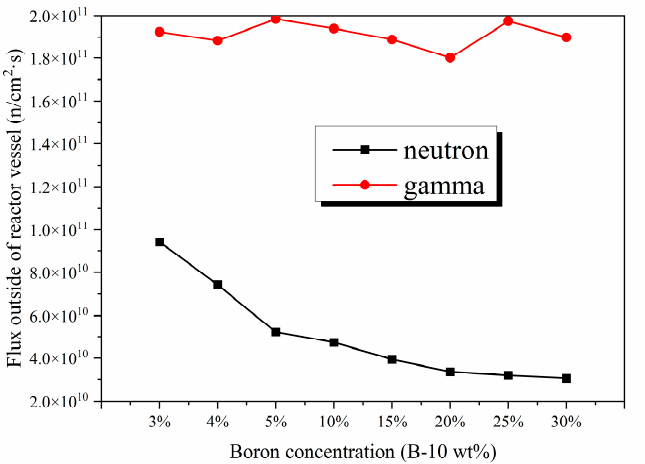
Figure 7. Neutron and gamma flux in the inner side of the reactor vessel with different boron contents in the Hastelloy barrel.